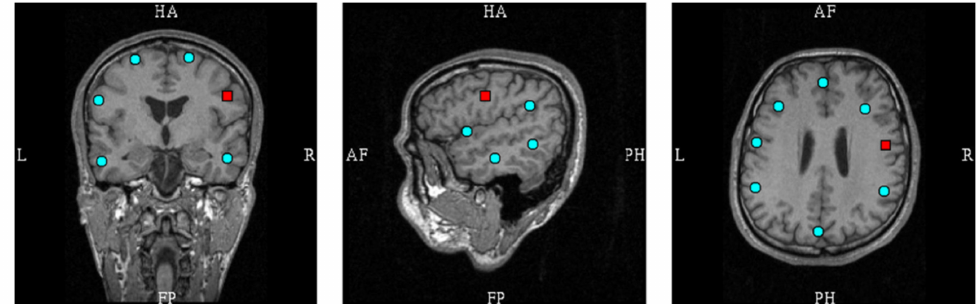
Figure 1. Subset of source montage dipoles overlaid on individual anatomical MR images. The red box indicates one location (FC6R) that was used for illustrative examples in Figure